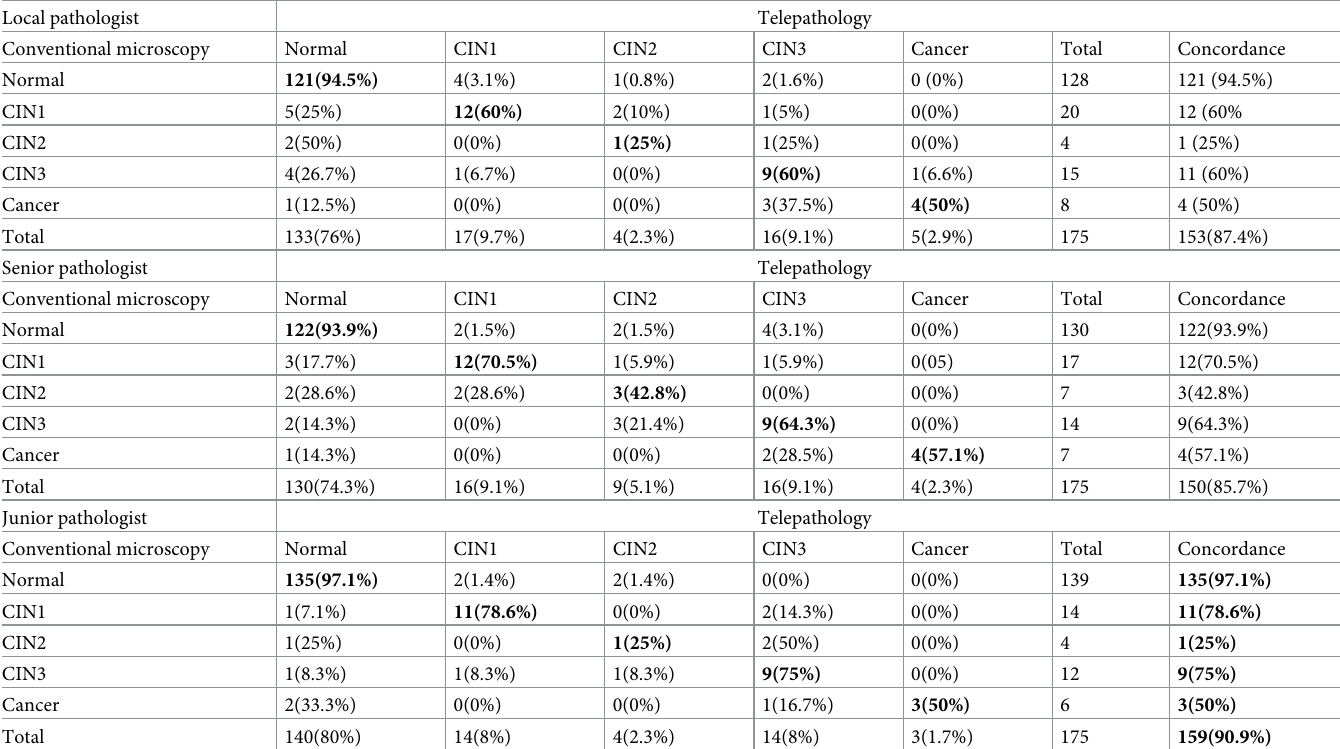
Table 1. Agreement of diagnoses established on telepathology compared to conventional microscopy across the pathologists. Local pathologist